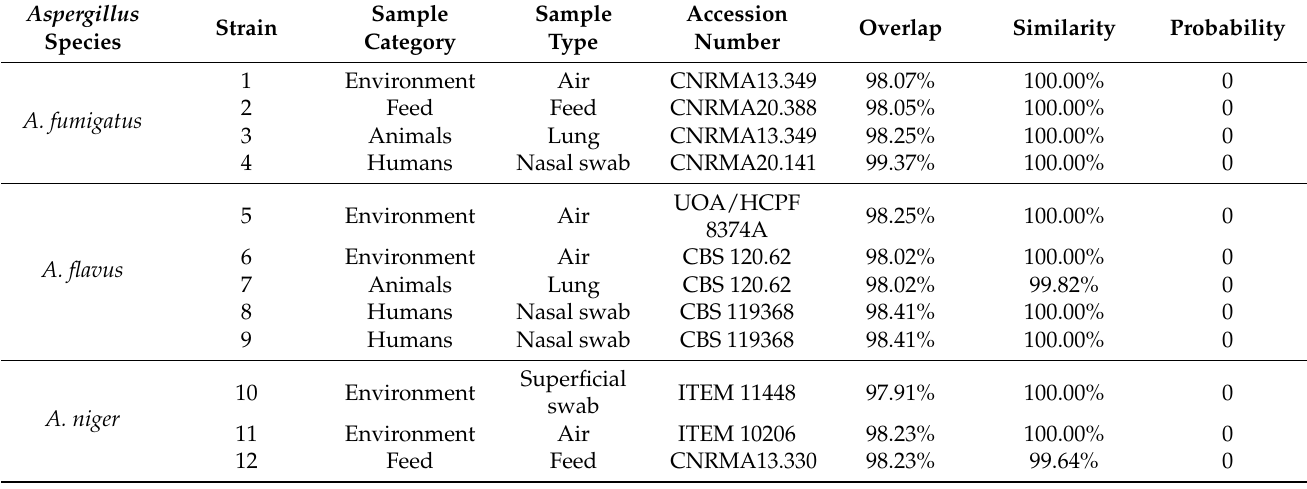
Table 4. Results of aspergilli sequencing.